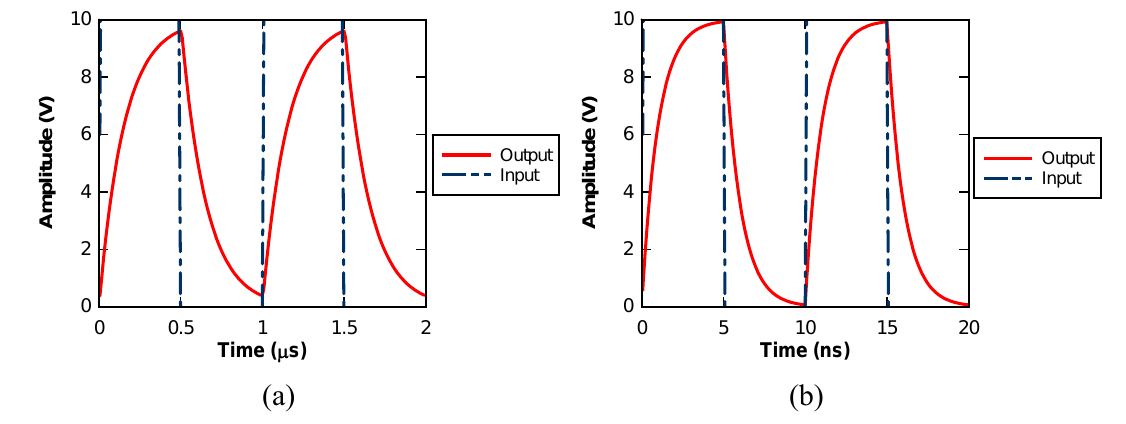
Figure 9. Input and output pair of A With three-metal layer at 100